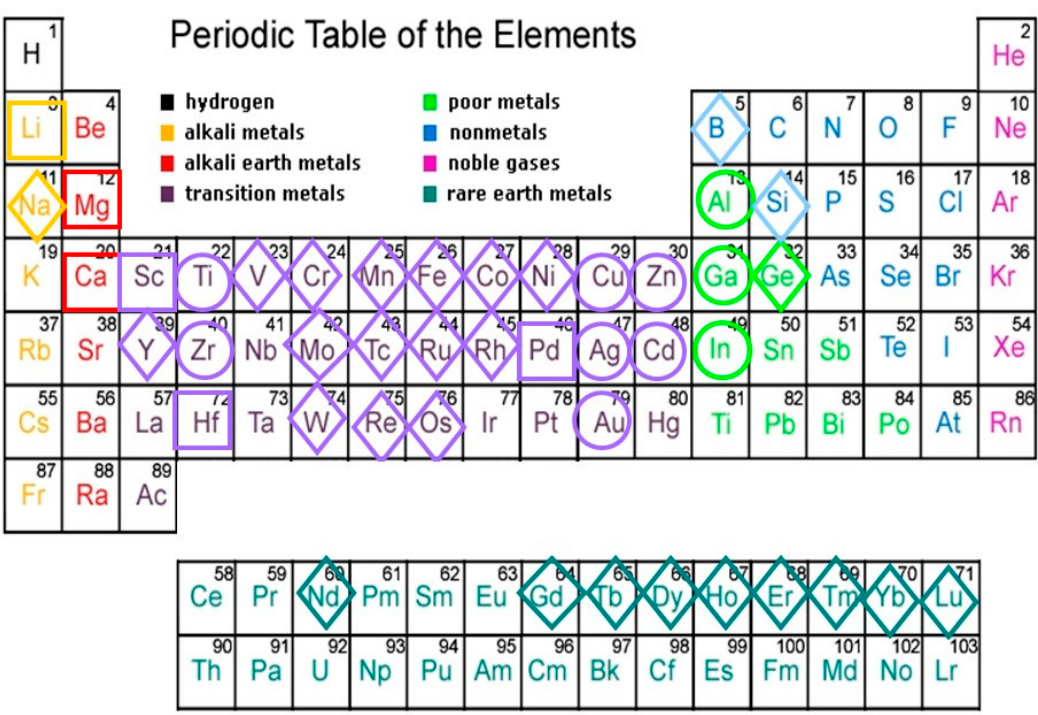
Figure 5. Chemical elements found in thermodynamically-stable QC alloys. Main forming elements (Al, Ga, In, Ti, Zr, Zn, Cd, Cu, Ag, and Au) are circled. The second major constituents are squared. Minor constituents are framed within a diamond.